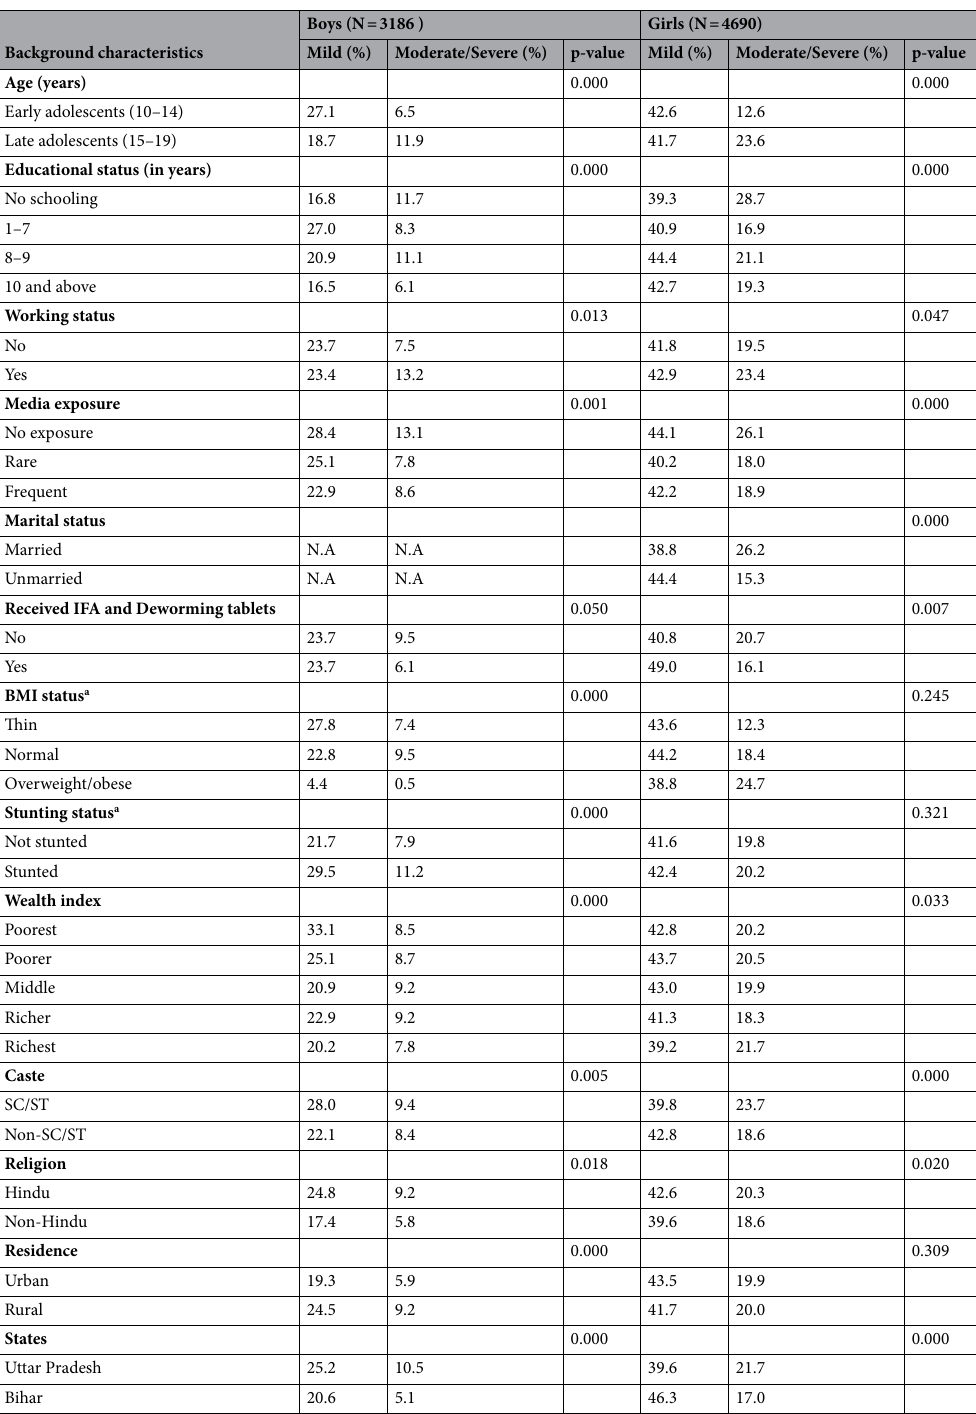
Table 2. Percentage distribution of anaemia among adolescents boys and girls by background characteristics. SC/ST: Scheduled Caste/Scheduled Tribe; NA: Not Available; a sample is low because of anthropometric measures eligibility; IFA: Iron Folic